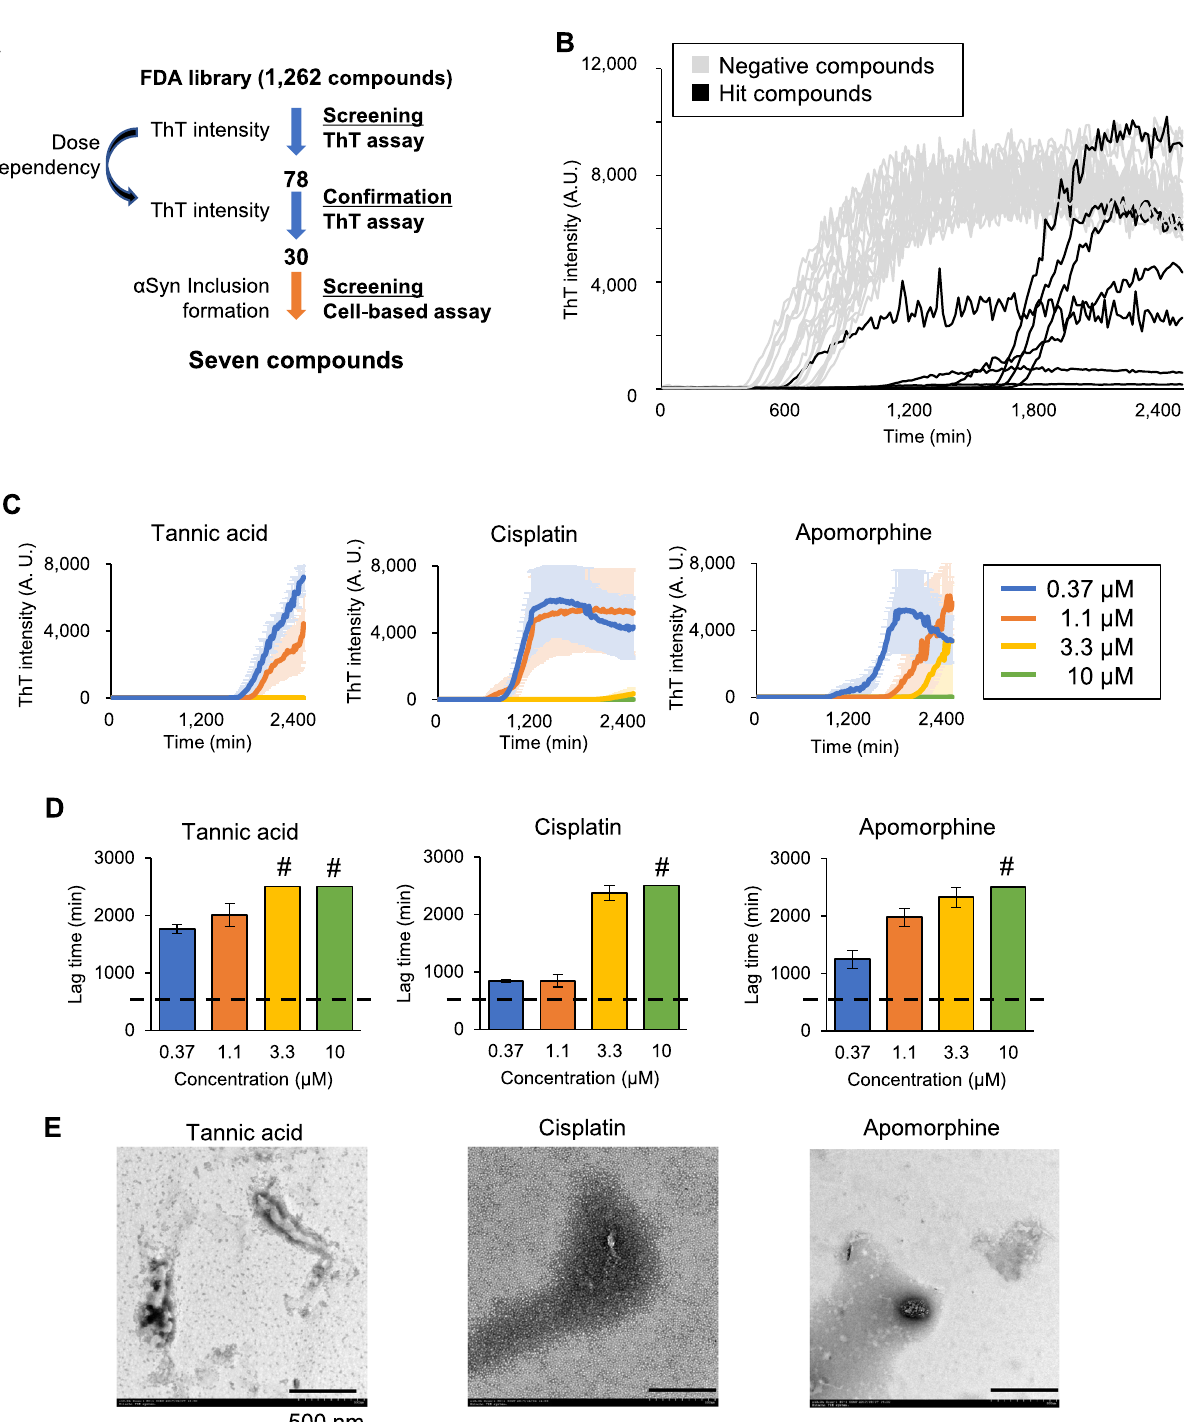
Figure 1. ThT fluorescence assay used for the screening of αSyn fibrillation inhibitors. ( A ) Schematic illustration of the two-step screening. ( B ) ThT kinetics of the wells with representative positive hits (black lines) and negative compounds (gray lines). ( C ) ThT kinetics of the top 3 hit compounds at different concentrations. Data are shown as the mean ± SEM of three independent wells (n = 3). Concentrations of the drugs are as indicated in the right box. ( D ) Representative lag times of the top 3 hit compounds at different concentrations. Dashed line represents the average lag times in the absence of any compound. Sharp marks (#) indicate that the reaction was stopped since it reached to the maximum duration (2505 min). Data are shown as the mean ± SEM of three independent wells (n = 3). ( E ) TEM visualization of fibrillation reaction products treated with the indicated compounds. Bar scale: 500